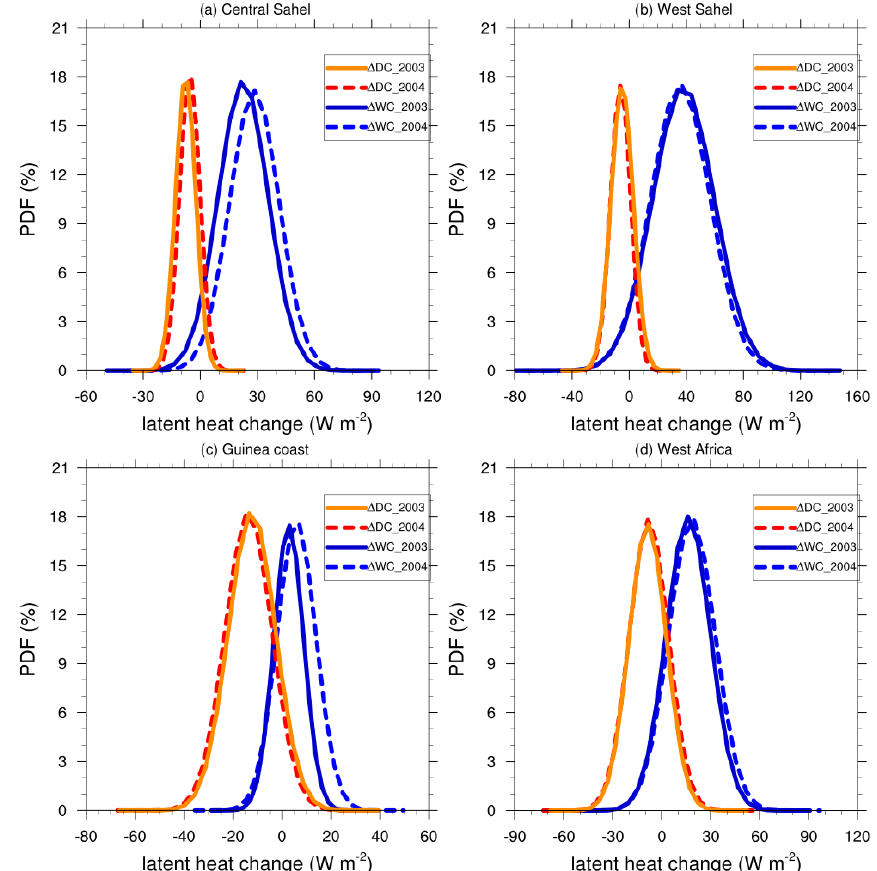
Figure 17. Same as Fig. 13 but for latent heat fluxes (in Wm − 2